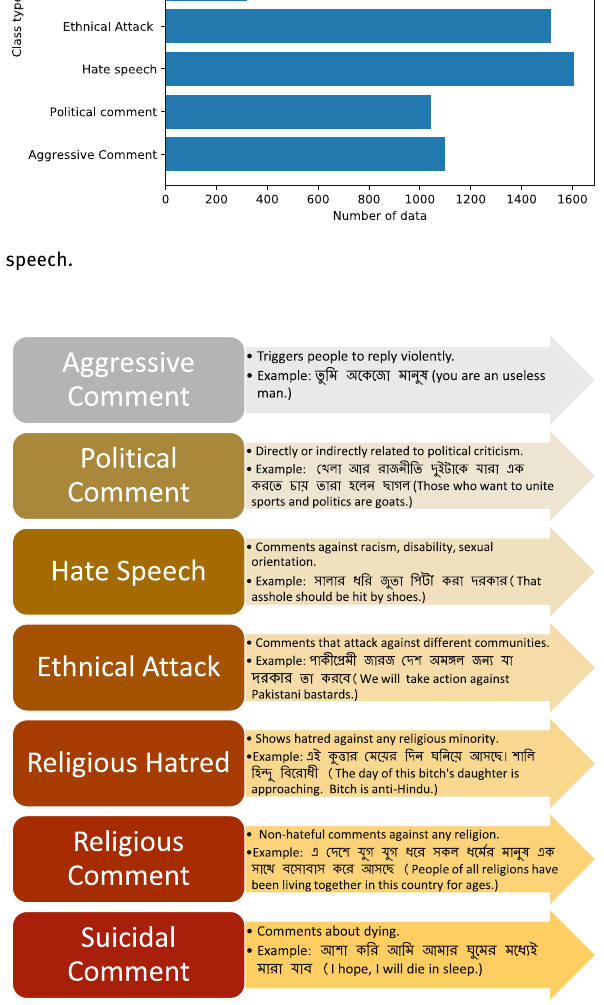
Figure 3: Displays the number of data each class